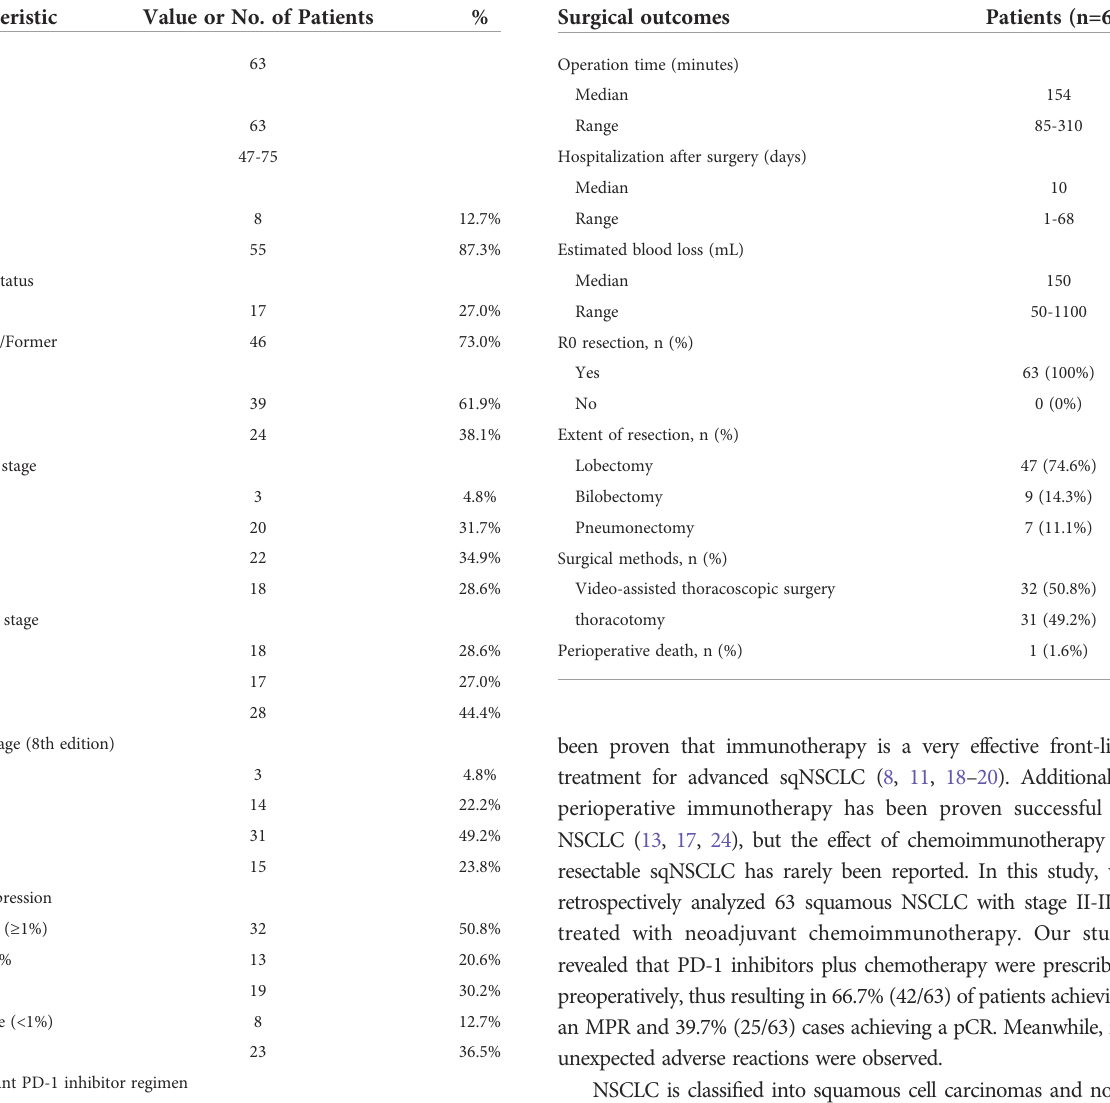
TABLE 1 Clinicopathologic characteristics of 63 patients. TABLE 2 Surgical